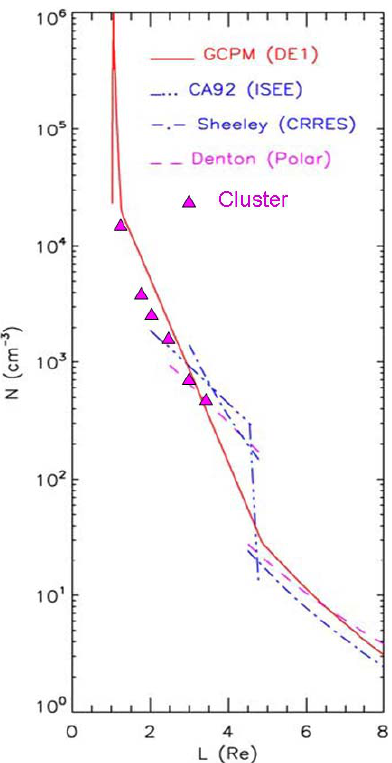
Fig. 8. Plasma density variation with L values. Estimates from F lh measurements on Cluster (values chosen shown in Fig. 7b), compared to empirical models (adapted from Pierrard and Stegen, 2008)